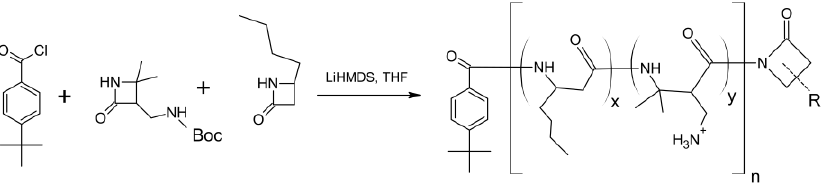
Figure 12. Synthesis of β -peptides by copolymerization of two different β lactams with the use of lithium bis(trimethylsilyl)amide as initiator and 4- tert -butylbenzyl chloride as co-initiator -based on [324].